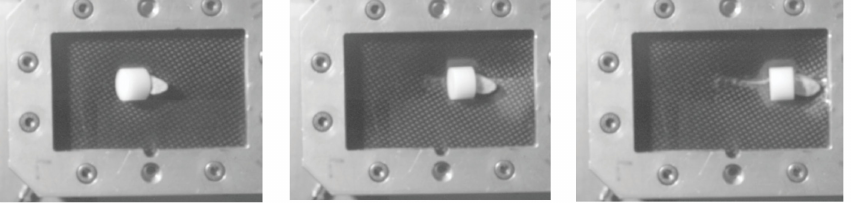
Figure 21. Sample 2 (CF, 28.5 degrees, 15.4 J), test n. 19, sharp gravel, showing the initial ( left ), intermediate ( centre ), and gravel detachment stages ( right ).